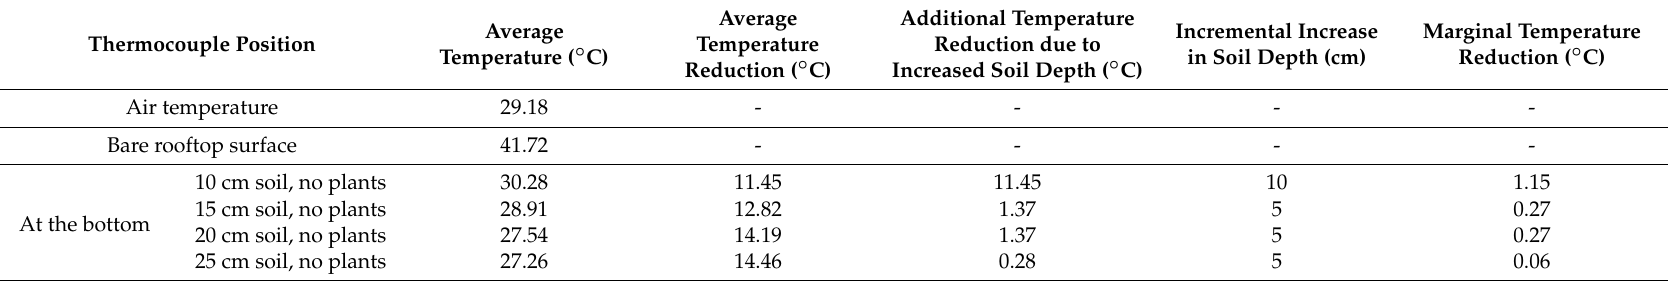
Table 4. Temperature reductions in the cases of 10, 15, 20, and 25 cm conventional garden-soil roofs without plants (14 May 2017 07:00–14:00). Thermocouple